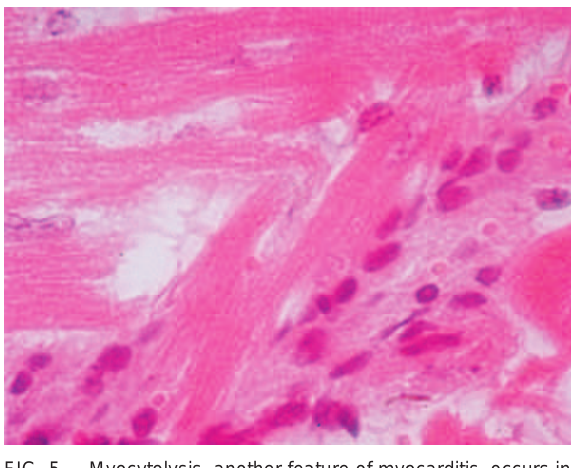
FIG. 5 Myocytolysis, another feature of myocarditis, occurs in addition to the inflammatory cell infiltrate in the left ven-